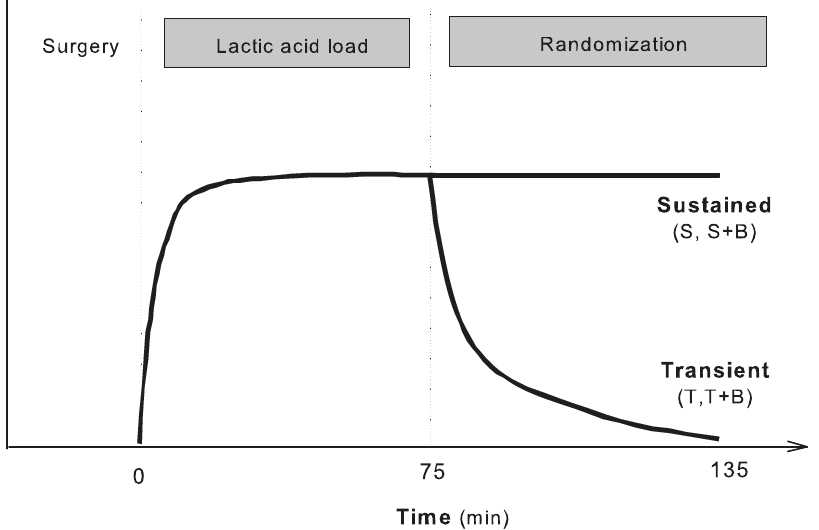
Figure 1. Protocol overview. A schematic overview of the experiment flow is shown in the figure. The investigation consisted of an initial lactic acid load to induce lactic acidemia followed by randomization to sustained (S) or transient (T) lactic acid infusion with or without sodium bicarbonate (B) treatment.